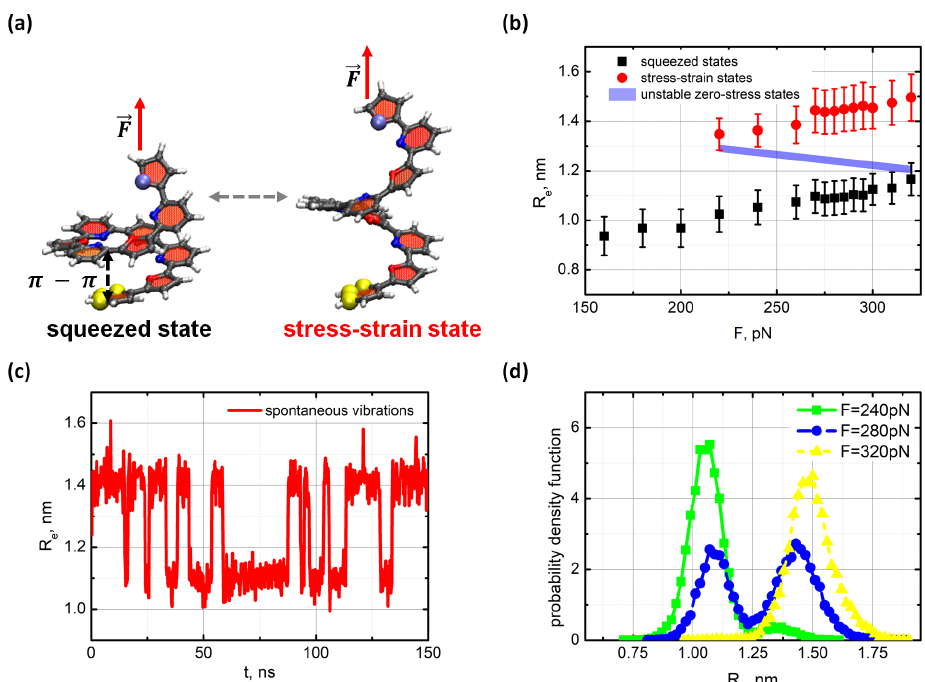
Figure 2. ( a ) Computational models of the oligo-PF-5 system with the applied longitudinal load. The squeezed and the stress–strain states of the spring are shown on the left and right, respectively. The yellow spheres at the lower end of the spring indicate the fixation of the pyridine ring by a rigid harmonic force. The pulling force, F , is applied to the top end of the spring. ( b ) The state diagram shows a linear elasticity of oligo-PF-5 spring up to F ≈ 220pN and bistability of the spring in the region from F ≈ 220–320pN; ( c ) Spontaneous vibrations of the oligo-PF-5 spring at F ≈ 279pN; ( d ) Evolution of the probability density for the squeezed and stress–strain states when pulling force surpasses the critical